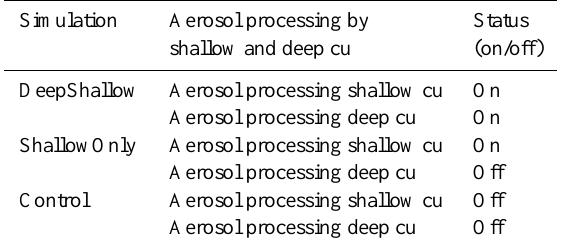
Table 2. Definitions of simulations completed as part of the study. The parameterized cumulus dynamics are applied in all